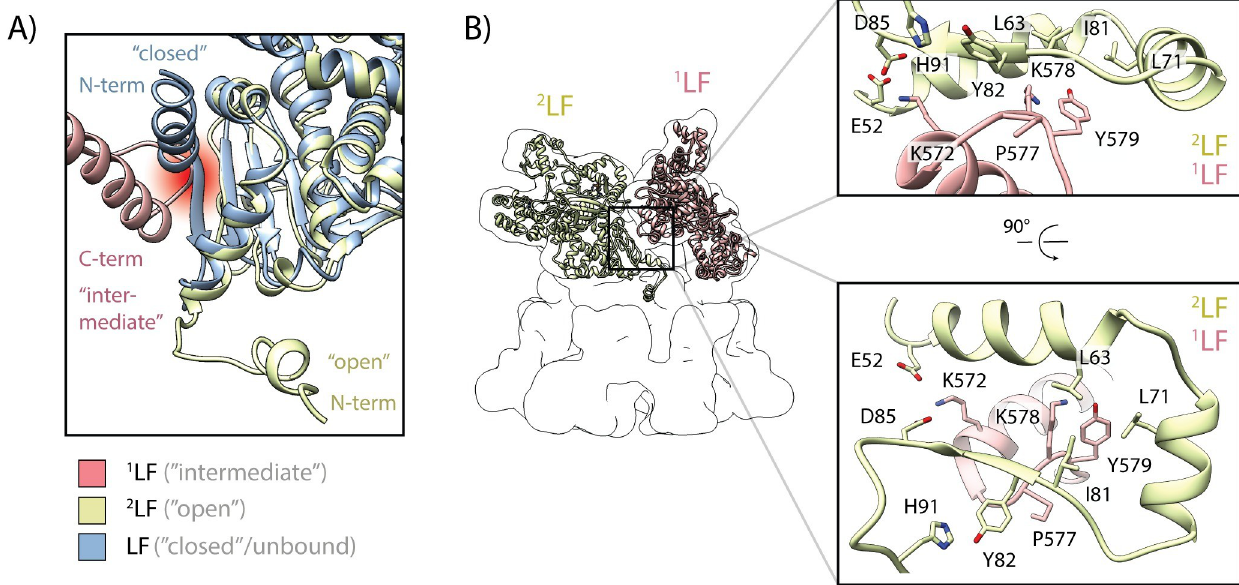
Fig 4. Molecular interface between two lethal factors. ( A ) Potential steric clash between the C-terminal domain of LF (red) and the N-terminal domain of an adjacent LF when it adopts the “closed” conformation (blue). The clash is highlighted as fading red spot in the background. In contrast, the “open” conformation (gold), i.e. the N-terminal α -helix interacts with the α -clamp region of PA, does not result in a steric clash. The N-terminal region of the red LF, which adopts an “intermediate” conformation, is not shown in this view. ( B ) A relatively small interaction interface mediates binding of the C-terminal domain of LF to the N-terminal domain of an adjacent LF. The positions of 1 LF (pink) and 2 LF (gold) are shown relative to the overall shape of the complex that is represented as transparent, low-pass filtered volume. A black square indicates the interaction interface between the two LFs. Insets show close-ups of the interacting regions in different orientations, with contributing residues